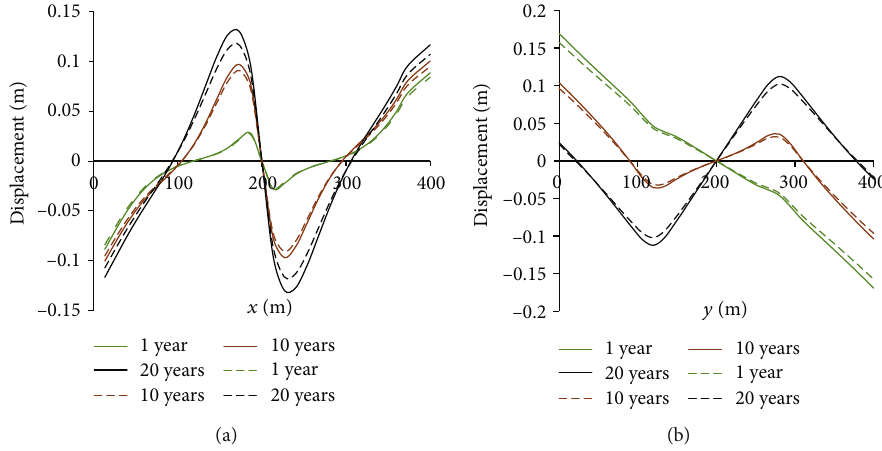
Figure 10: (a) and (b) present the displacement pro fi les on Paths A and B.